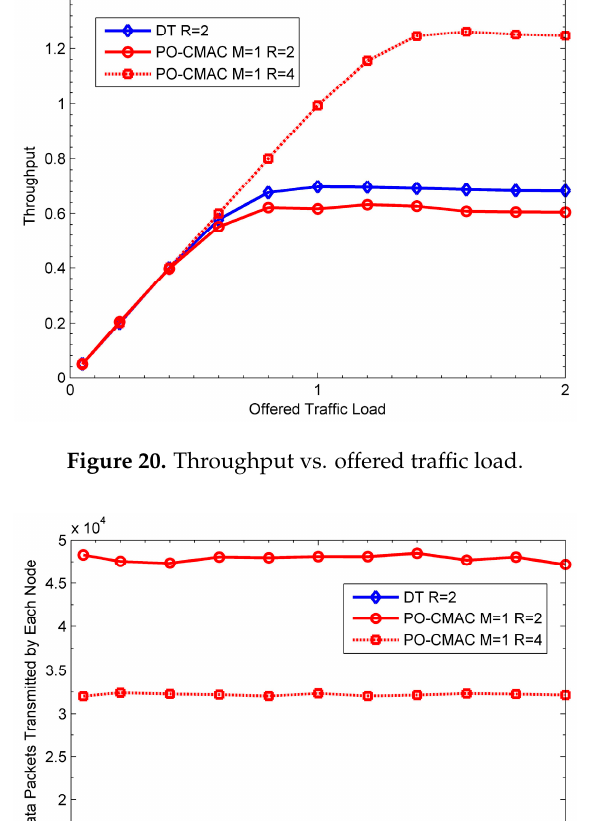
Figure 20. Throughput vs. offered traffic load.